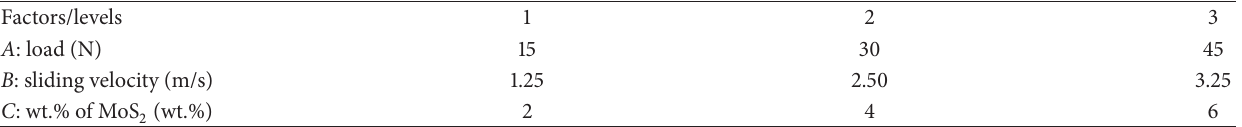
Table 3: Affecting factors and levels selected for Tribology Al6061/12wt.% Al 2 O 3 /MoS 2 .